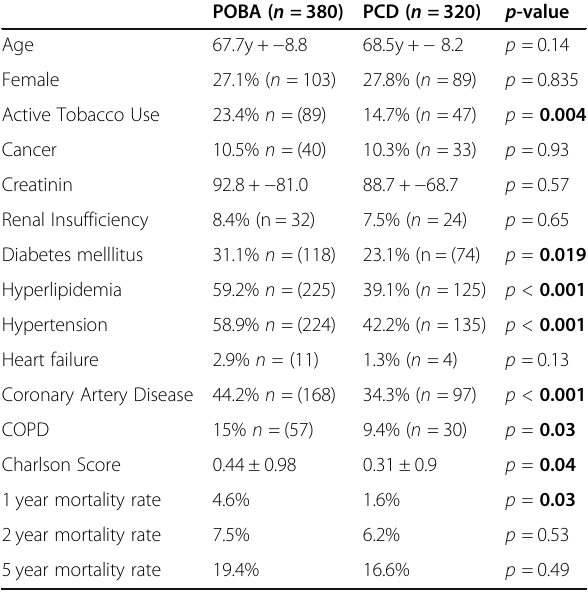
Table 1 Comparison of the baseline characteristics of the patients in the PCD and POBA groups and the 1, 2 and 5 years mortality